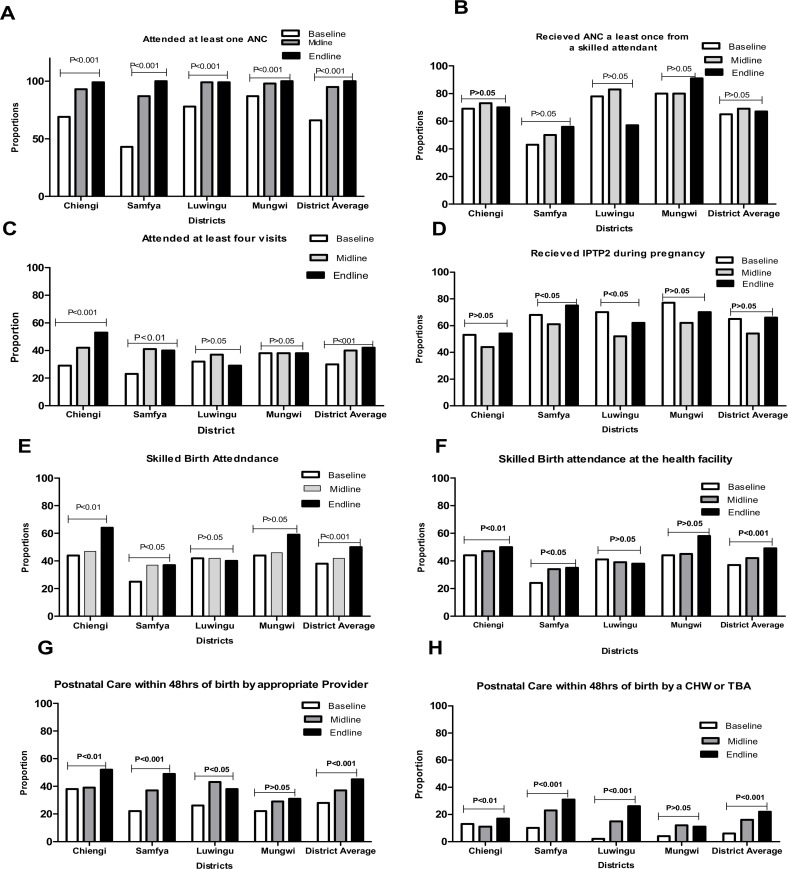
Trends and differentials in the coverage for ANC, SBA and PNC indicators over a three year period.